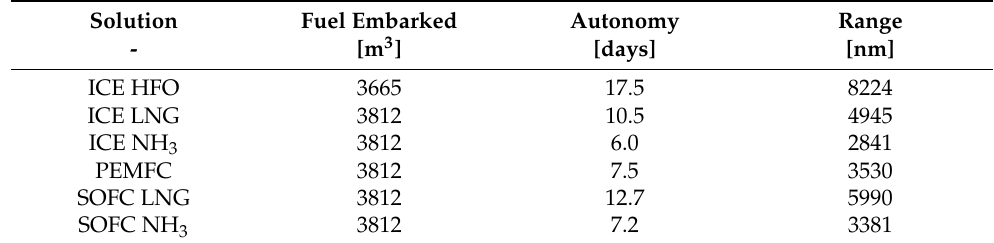
Table 12. Comparison of autonomies and ranges for each propulsion alternative at cruise